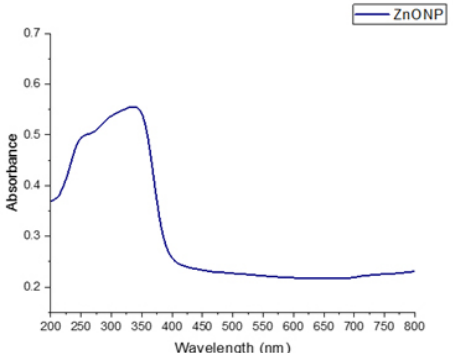
Figure 2. UV–Visible spectroscopy of synthesized